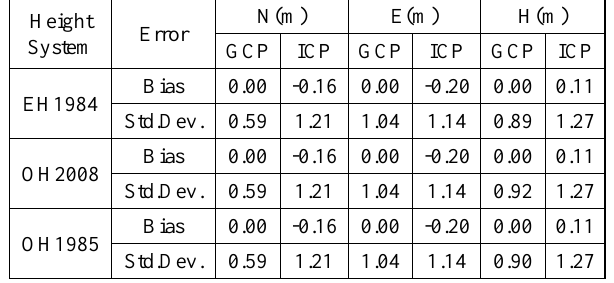
Table 6. The bias and the standard deviation of 8 GCPs and 125